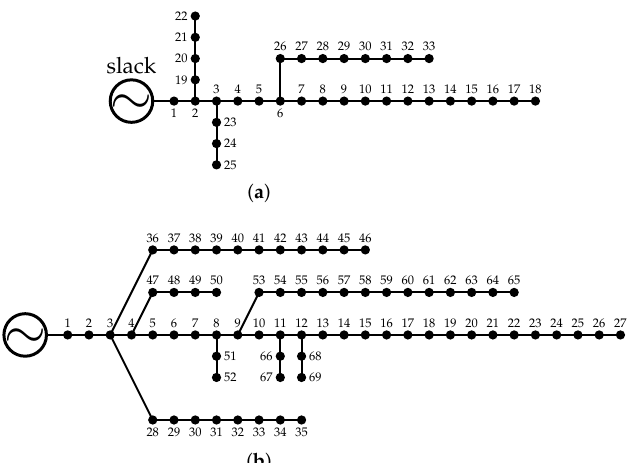
Figure 5. Electrical configuration of the test systems: ( a ) IEEE 33-node system and ( b ) IEEE 69- node